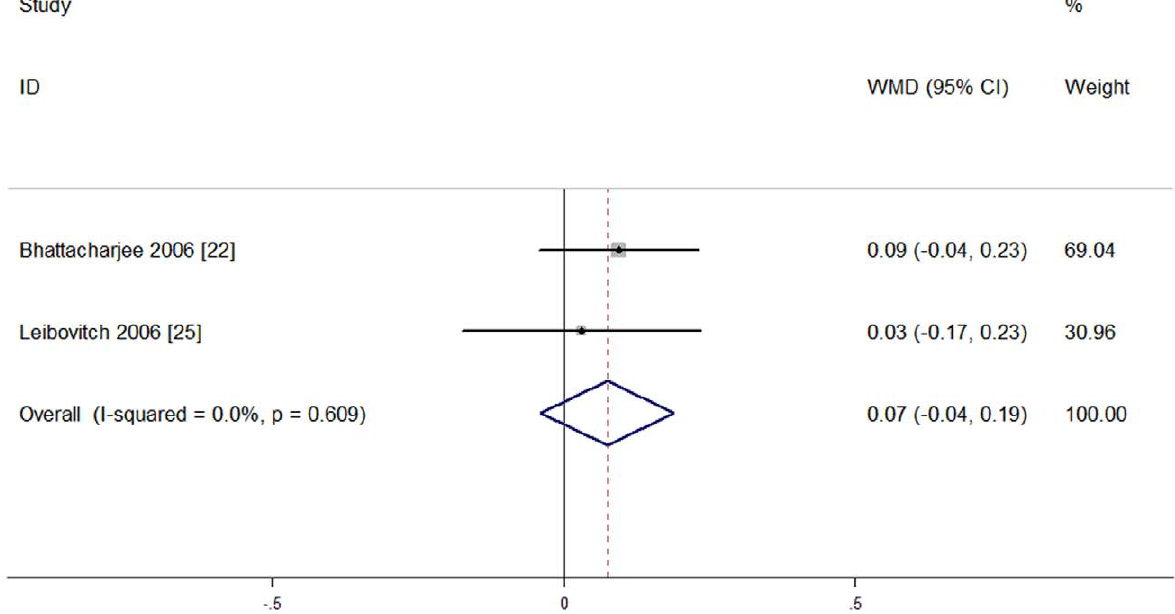
Figure 4. Meta-analysis of postoperative contrast sensitivity. doi:10.1371/journal.pone.0033013.g004 PLoS ONE |